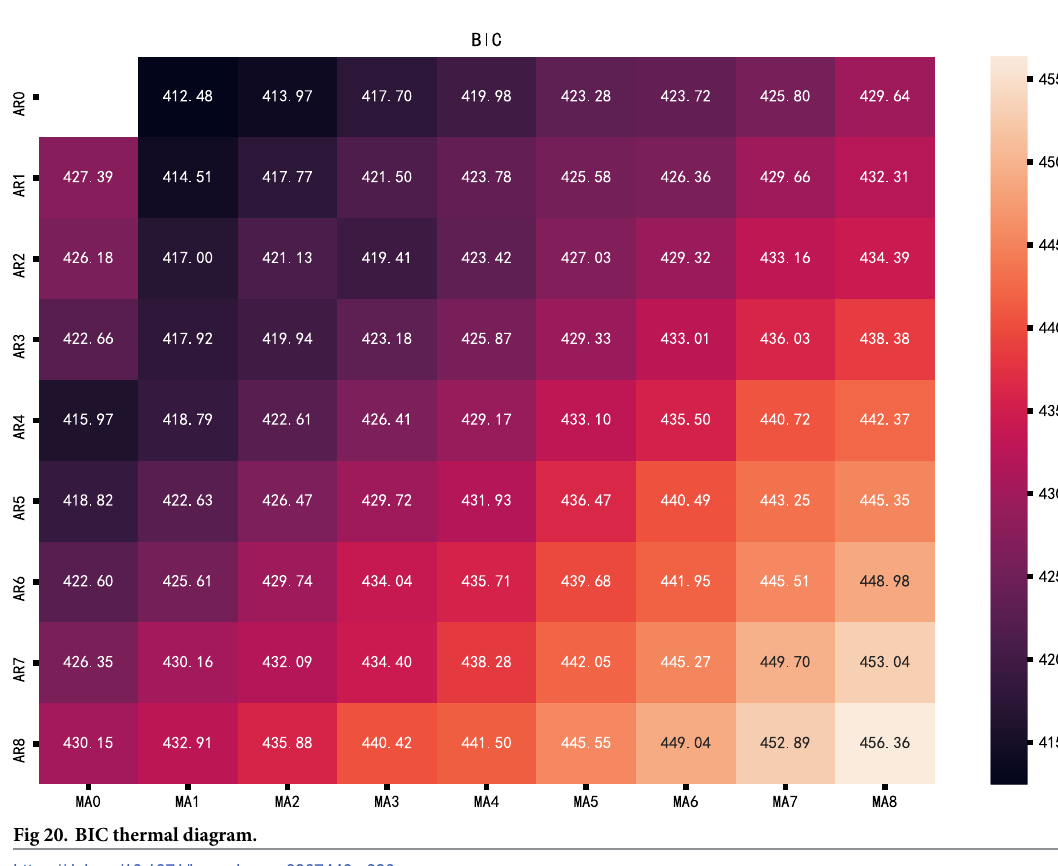
Fig 20. BIC thermal diagram.